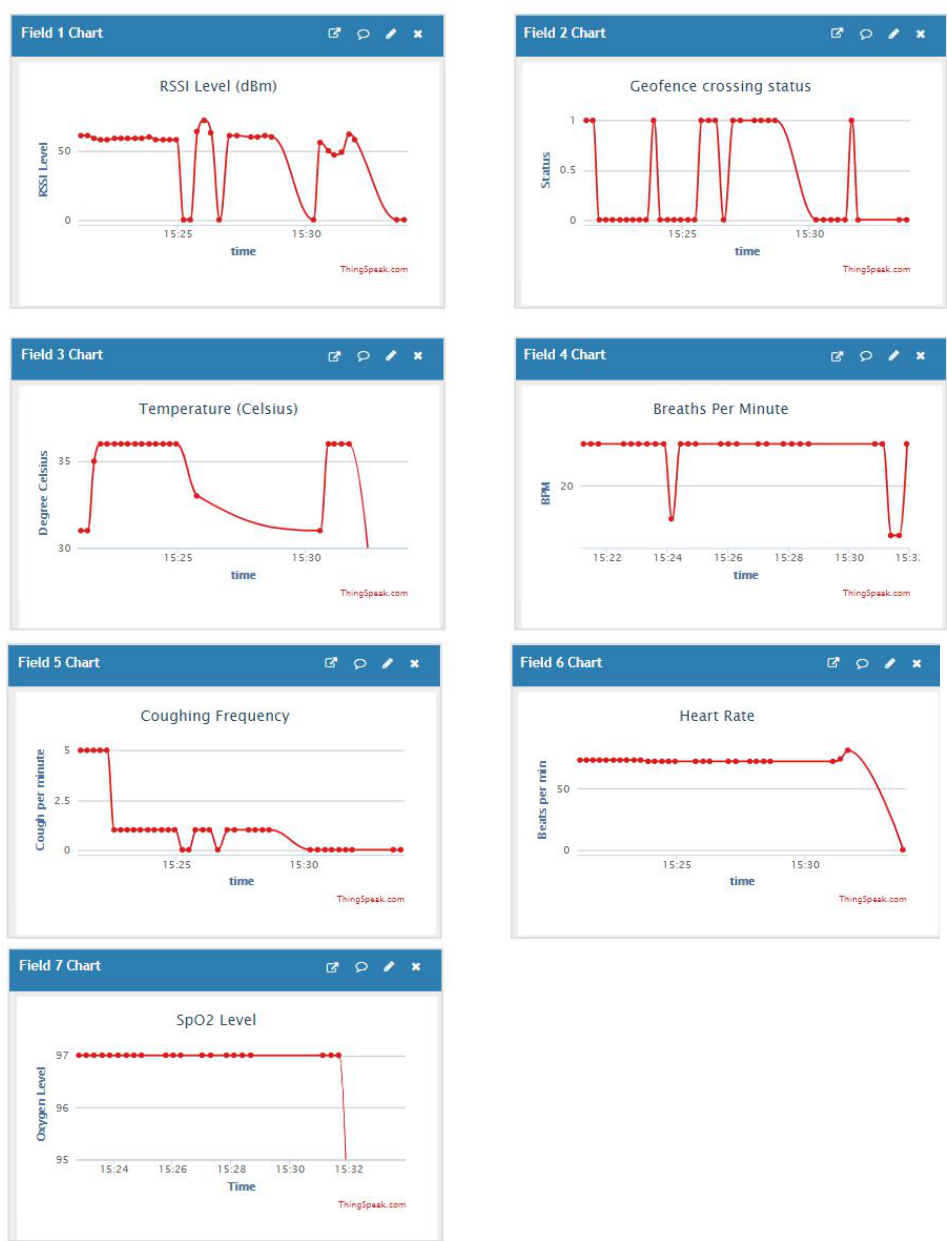
Figure 16. ThingSpeak Channel visualization available at https://ThingSpeak.com/channels/1261 115, accessed on 19 August